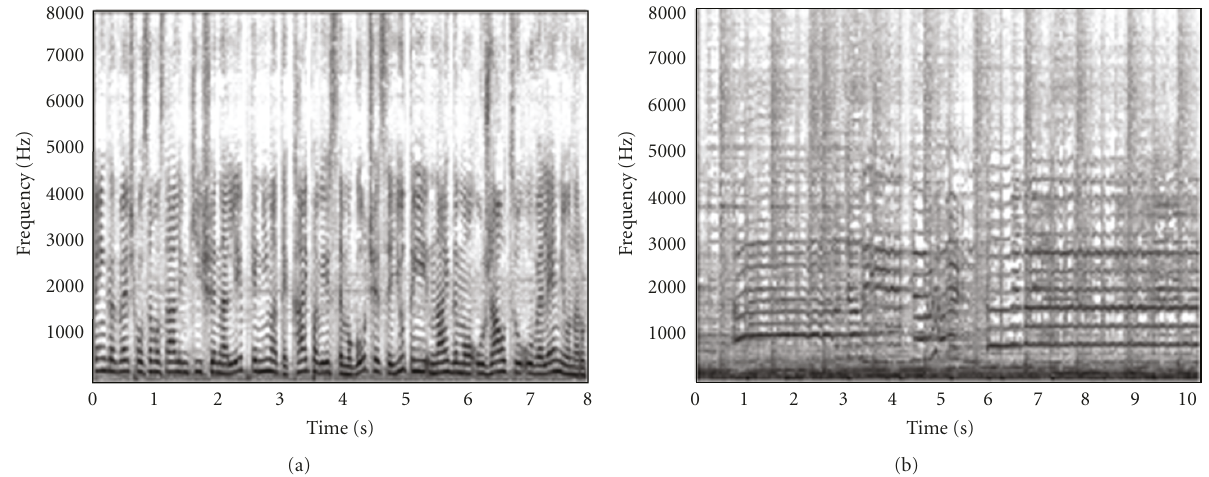
Figure 1: Spectrograms of (a) Speech of a female radio speaker, (b) music including vocals, recorded from public broadcast radio station.